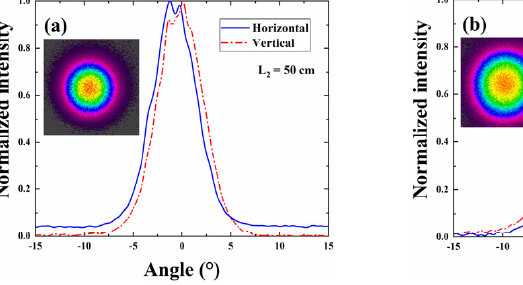
Figure 9. One-dimensional far-field modes of VECSEL measured at different transmission distances L 2 of ( a ) 50, ( b ) 100, and ( c ) 150 cm. The beam profiles of VECSEL are shown in the inset images.